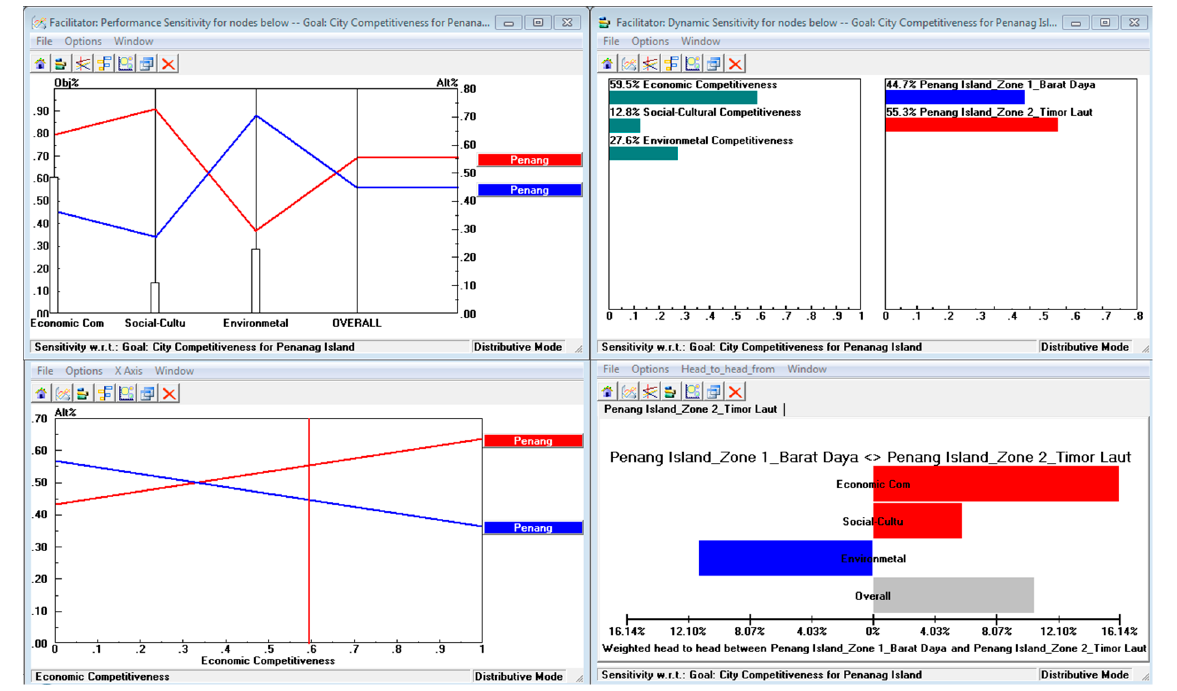
Figure 5. Dynamic, gradient, head-to-head, 2D-sensitive analysis chart of urban landscape criteria and alternatives in the Expert Choice score.